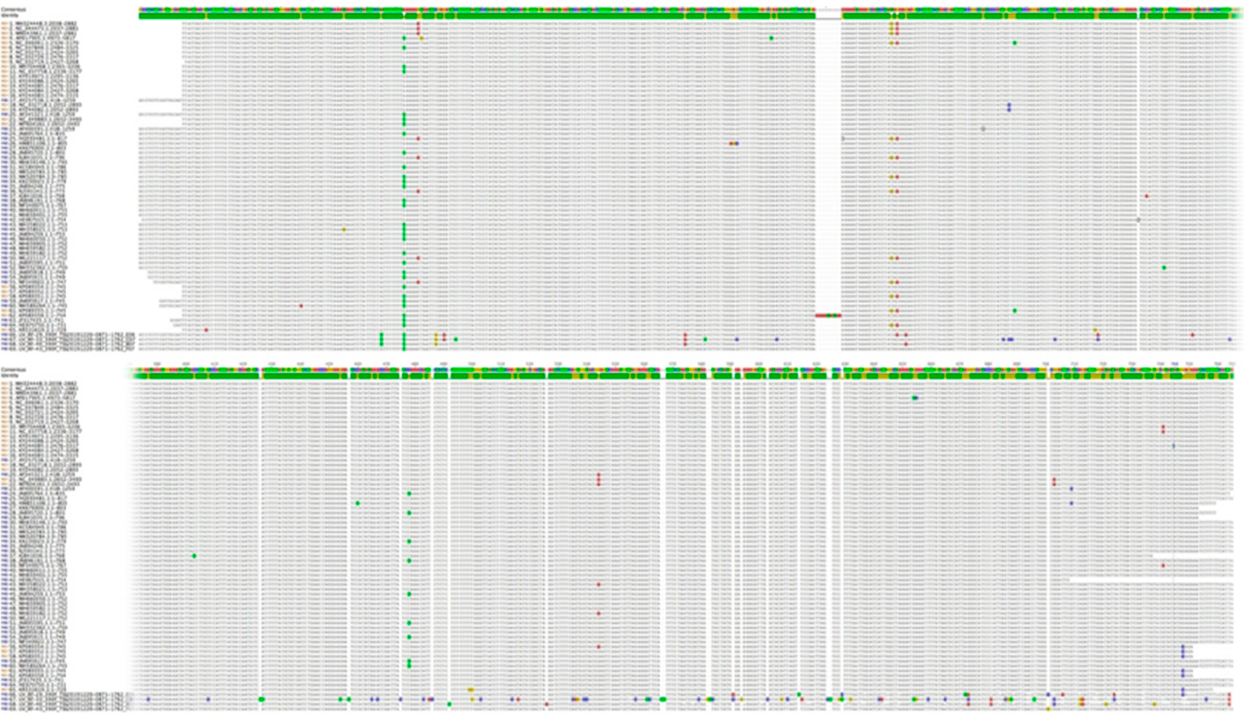
Figure 4. Multiple sequence alignment of the matK 390F + 1326R sequences of U. villosa from Pakistan. Different colors indicate the SNPs within the matK region.